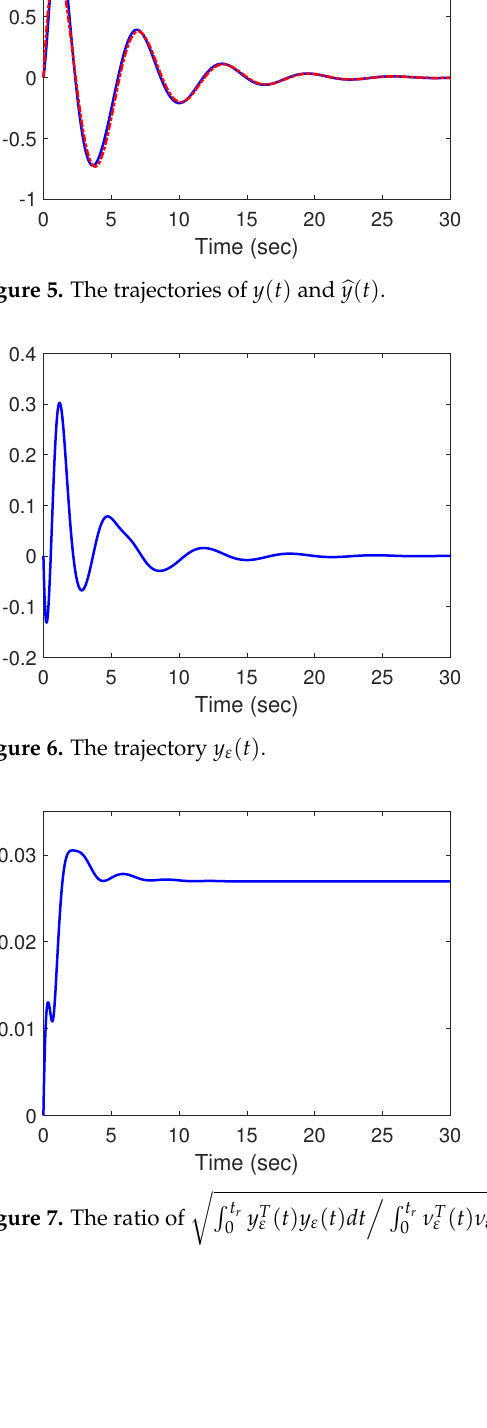
Figure 7. The ratio of